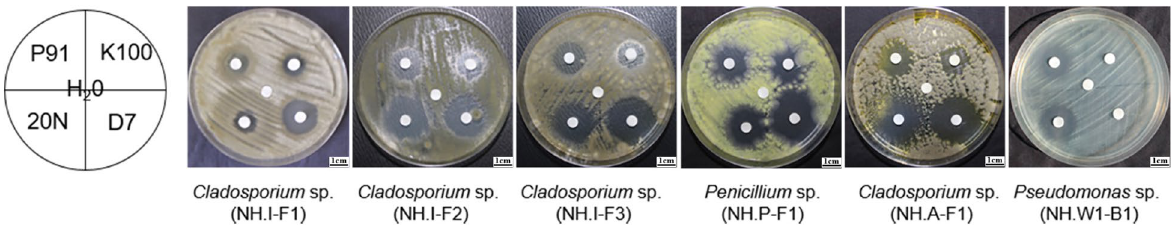
Fig. 4 The sensitivity of culturable fungi and dominant bacteria to biocides. The size of the inhibition zone indicates the inhibitory effect of biocides on culturable strains. The fungi were cultured at 28 ℃ for 3 days, and the bacteria were cultured at 37 ℃ for 1 day